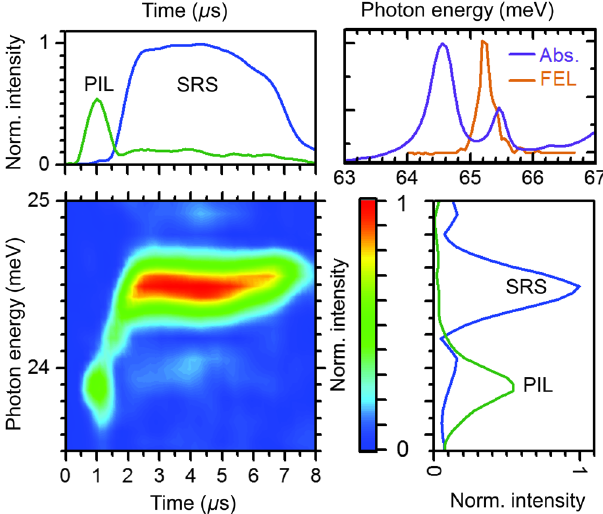
6. (See also the complementary files with reconstructed dynamics [18].) Temporal and spectral evolution of the Si ∶ Bi laser emission when pumped at 19 . 02 μ m (65.2 meV) which is 0.6 meV above the long-lived 2 p state (color map with (cid:2) projections to time and photon energy axis). The emission lines at approximately 23 . 8 meV (5.78 THz) and at 24.5 meV → 1 s ð E Þ transition and (5.92 THz) correspond to the PIL 2 p (cid:2) to the Raman emission from a virtual state into the 1 s ð E Þ state, respectively. The FWHM is about 0 . 25 meV and the spectral FEL resolution of the Fourier-transform infrared spectrometer is 37 μ eV ( 0 . 3 cm − 1 ). The right upper graph shows the Si ∶ Bi absorption spectrum compared with the FEL pump